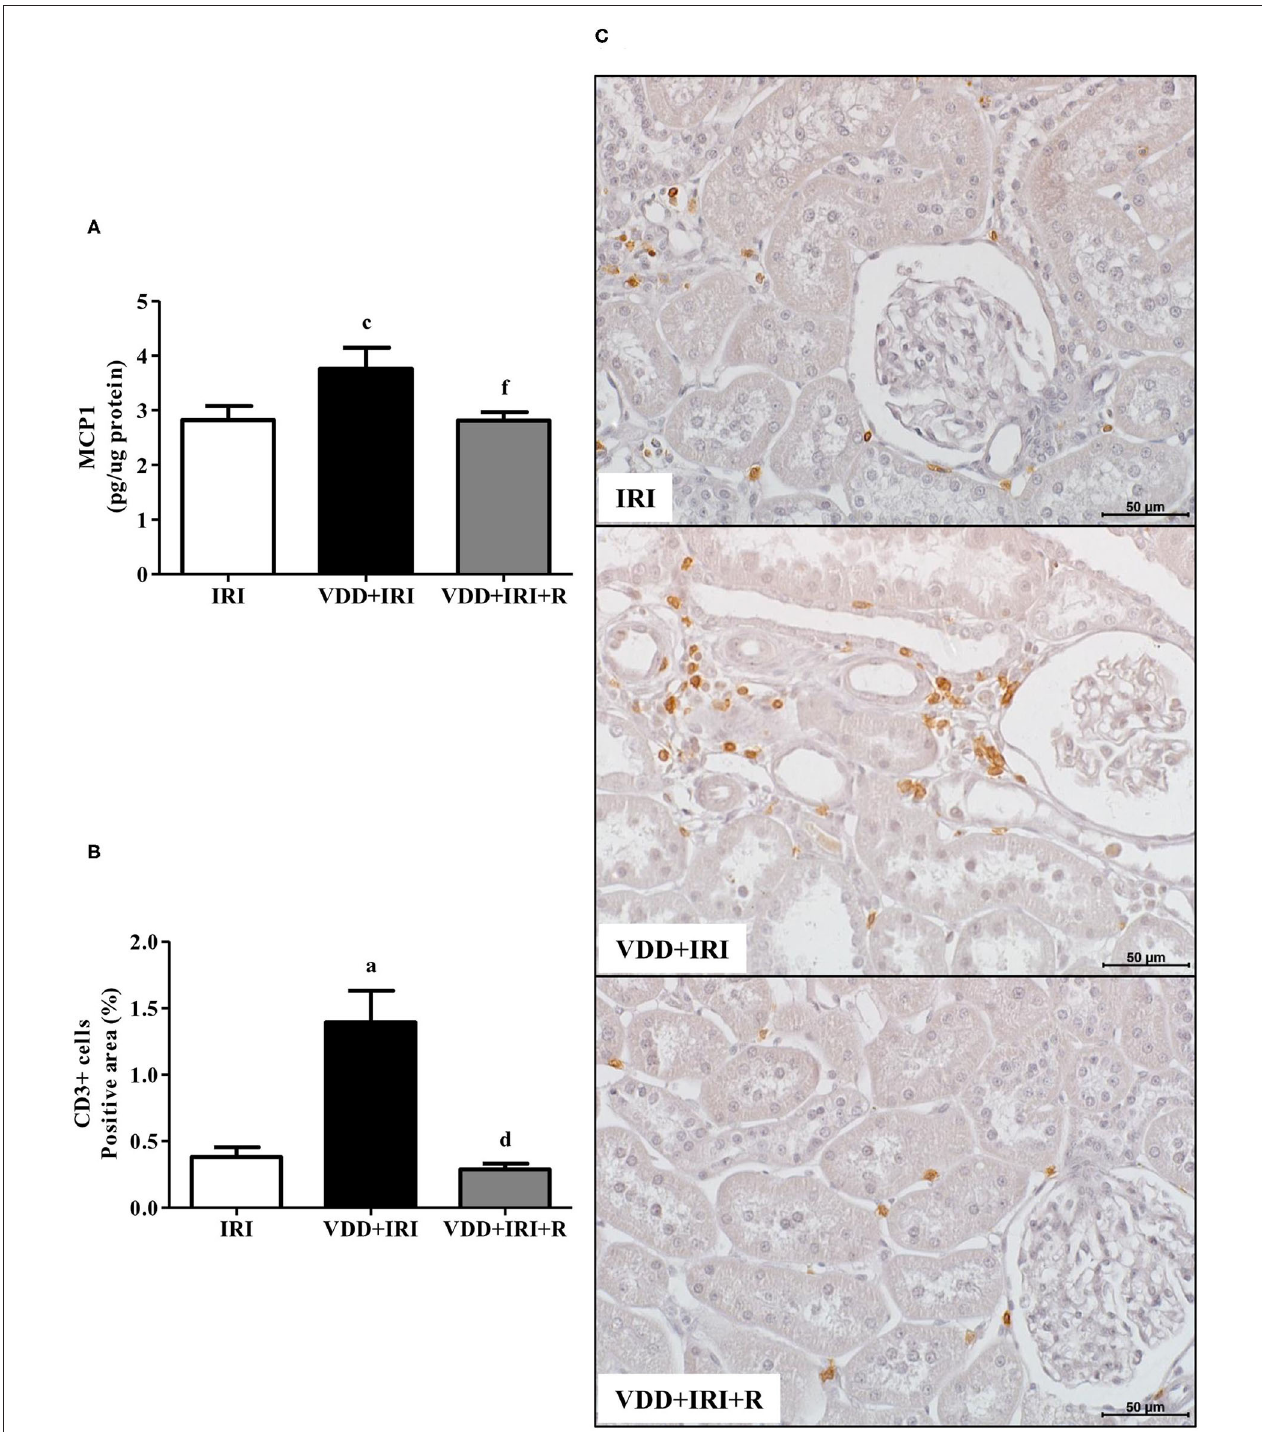
FIGURE 3 | Quantitative amount of Monocyte Chemotactic Protein 1 (MCP1)—ELISA and immunohistochemical analysis of CD3 + cells (T cells) expression in the kidney tissue evaluated 90 days after ischemia/reperfusion insult (IRI) on day 30. (A) Bar graphs of MCP1 and (B) CD3 + cells expression values. (C) Representative photomicrographs of immunostaining for CD3 + cells in the renal cortex from an IRI, VDD + IRI and VDD + IRI + R rat ( × 400). Note that vitamin D replacement restored the expression of both MCP1 and CD3 + cells in the VDD + IRI + R rats. Data are mean ± SEM. a p < 0.001, c p < 0.05 vs. IRI; d p < 0.001, f p < 0.05 vs. VDD + IRI. VDD, vitamin D deficiency; R, vitamin D replacement. Diet protocol: IRI, standard diet for 120 days; VDD + IRI, vitamin D-free diet for 120 days; and VDD + IRI + R, vitamin D-free diet in the first 30 days and standard diet in the last 90 days.